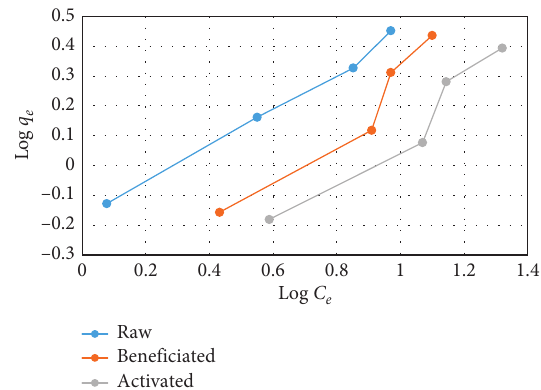
Figure 12: Freundlich isotherm model for different adsorbents (raw, beneficiated, and activated ash) at constant dosage 25mg/L, pH optimum 8 for raw and 12 for beneficiate and activated ash, contact time 100min, shaker speed 100rpm, room temperature, and concentration 25–100mg/L within 25mg/L intervals.